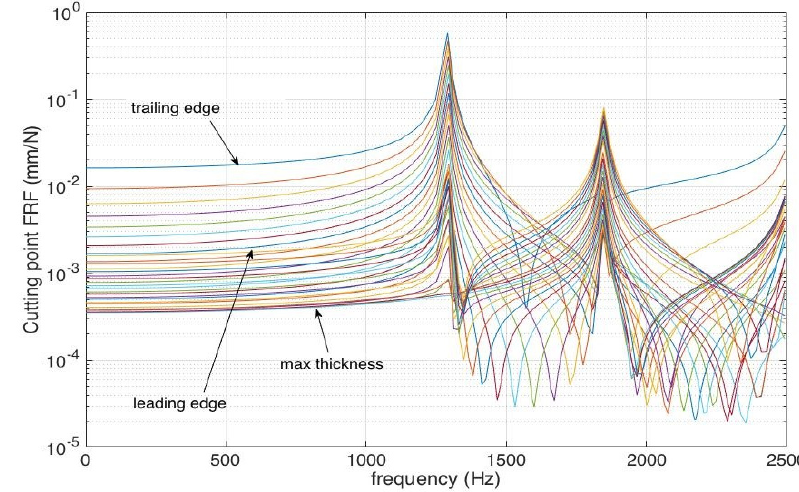
Figure 9. Compliance at the tip of the blade moving from the trailing to the leading edge.